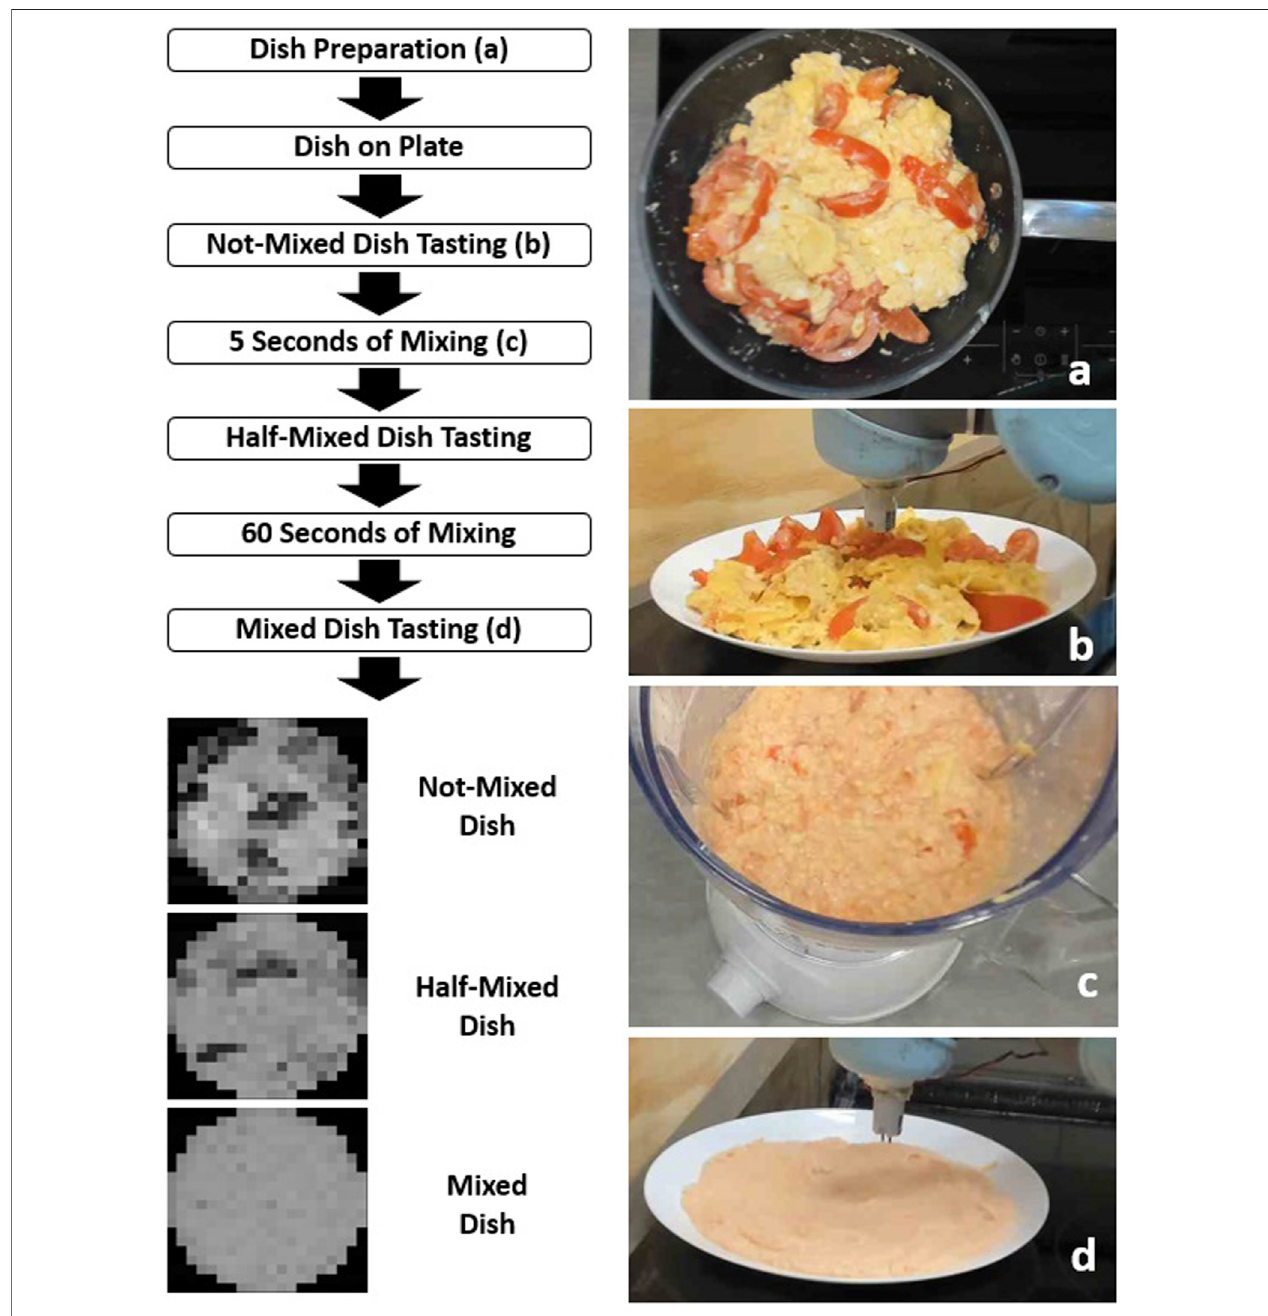
FIGURE 4 | The experimental procedure used to taste a dish at various stages of chewing. (a) the dish is prepared according to a recipe. (b) robot sampling unmixed dish. (c) mastication is represented by mixing. (d) robot sampling mixed dish.